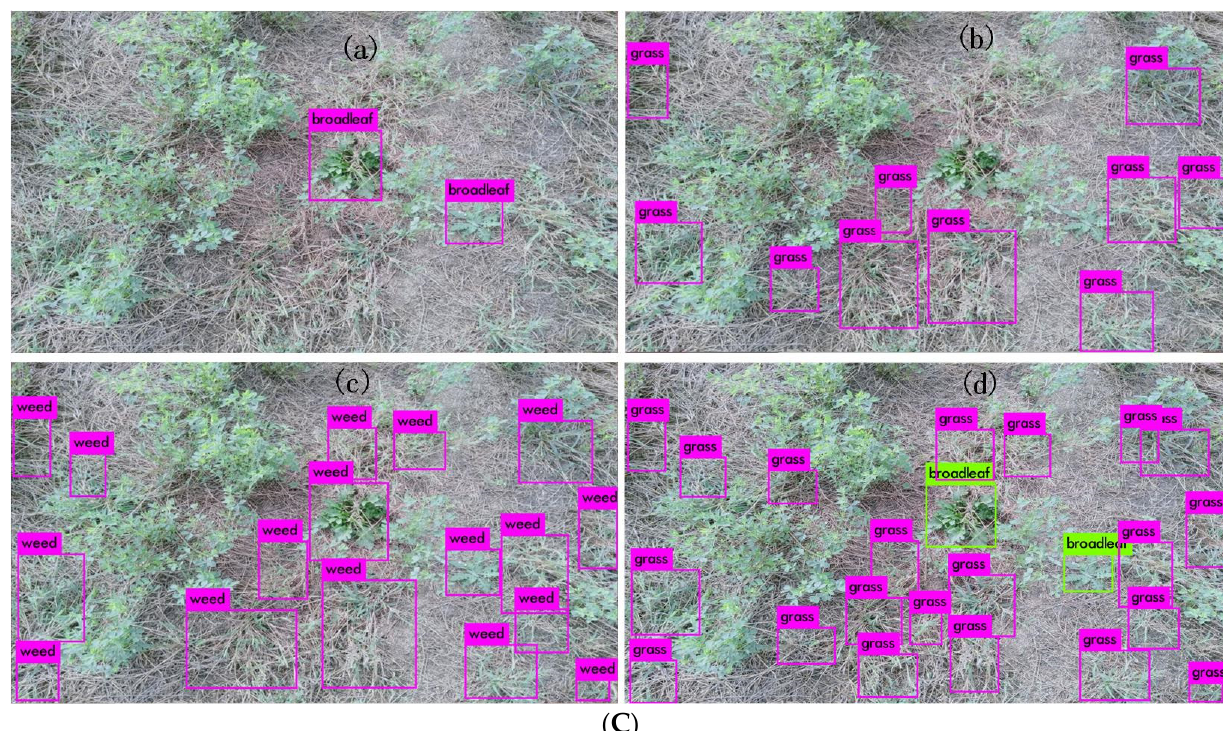
Figure 1. The detection of weeds growing in alfalfa using object detection neural networks. ( A ) Weed detection based on Faster R-CNN. ( B ) Weed detection based on VFNet. ( C ) Weed detection based on YOLOv3. ( a ) The training dataset only contained broadleaf weeds to detect broadleaf weeds growing in alfalfa. ( b ) The training dataset only contained grass weeds to detect grasses growing in alfalfa. ( c ) The training dataset contained both broadleaf and grass weeds to indiscriminately detect both broadleaf and grass weeds growing in alfalfa. ( d ) The training dataset contained broadleaf and grass weeds to detect and discriminate between broadleaf and grass weeds growing in alfalfa.